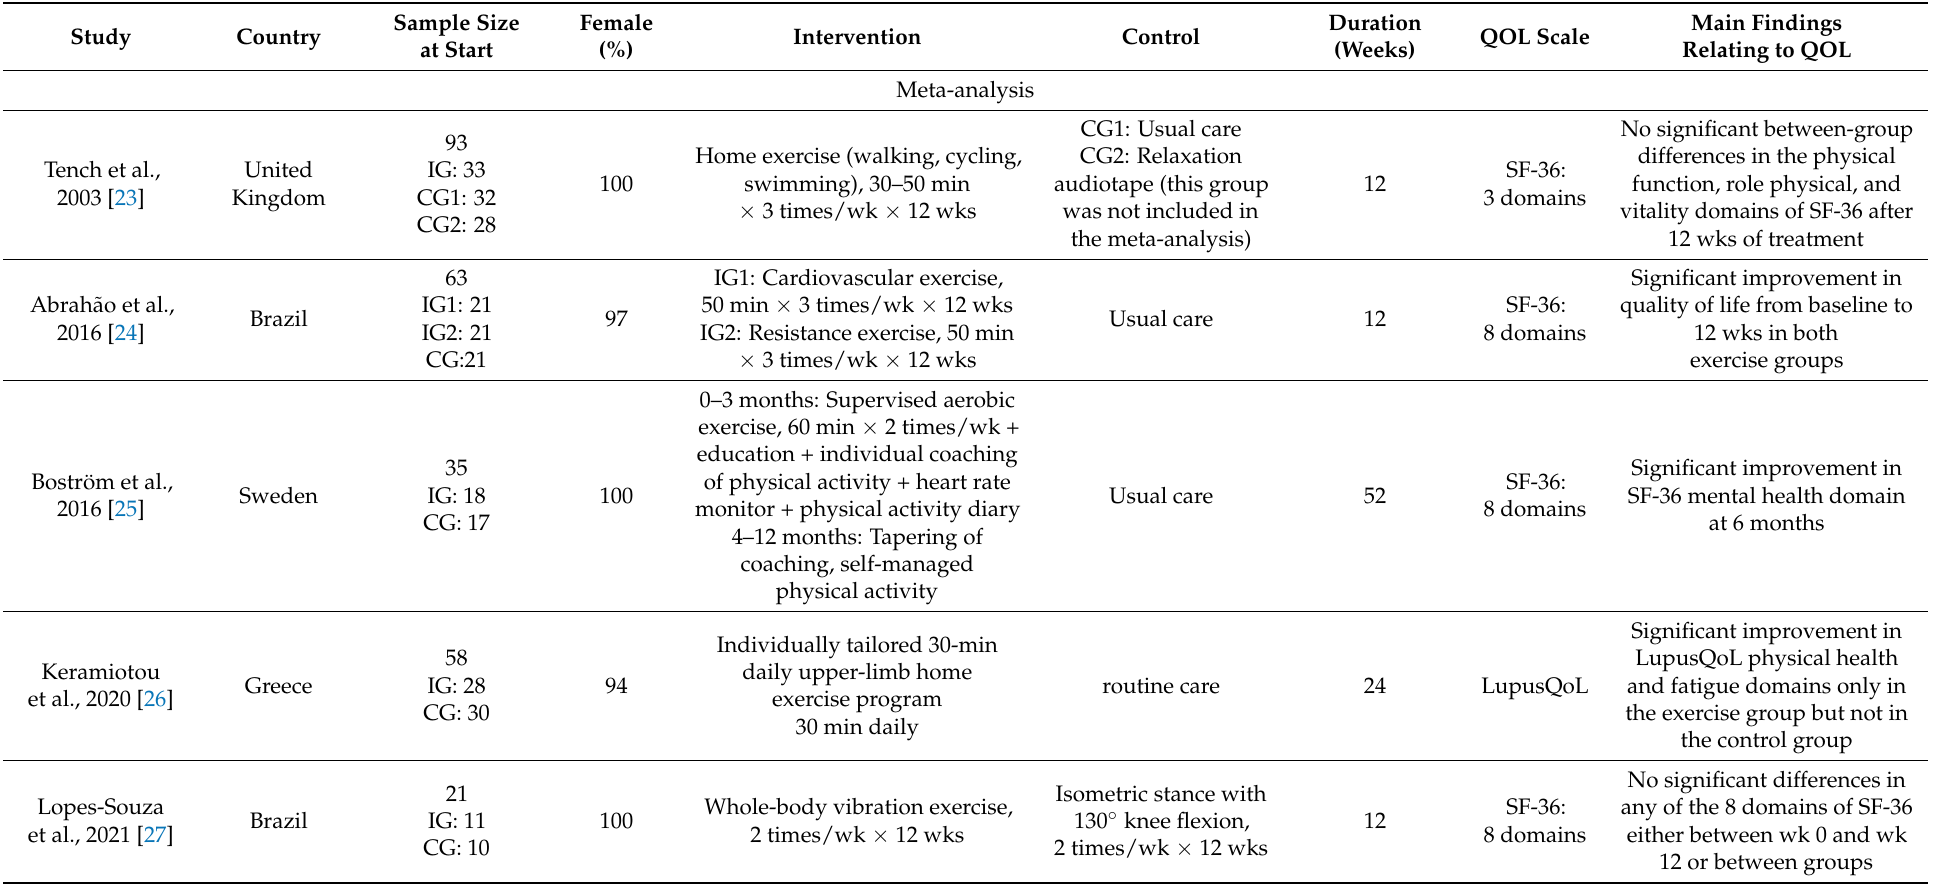
Table 1. Summary of the included controlled trials in the systematic review and